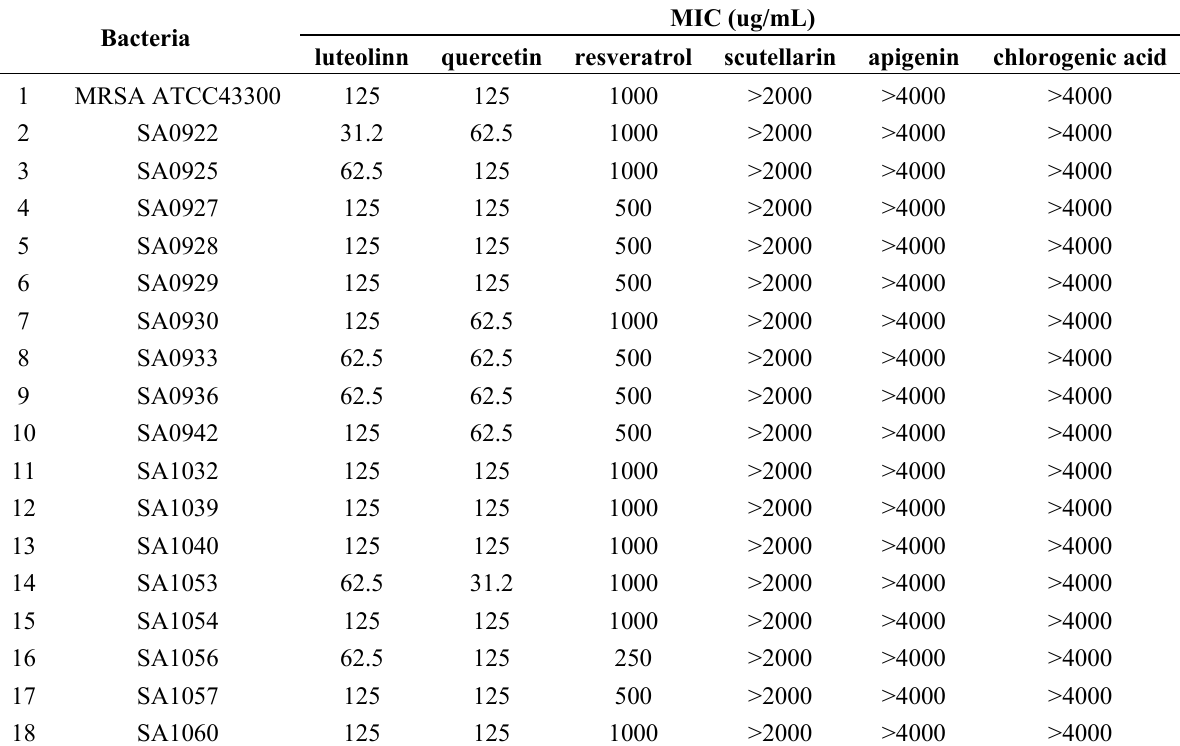
Table 1. MICs of six polyphenols against 34 isolates of S . aureus